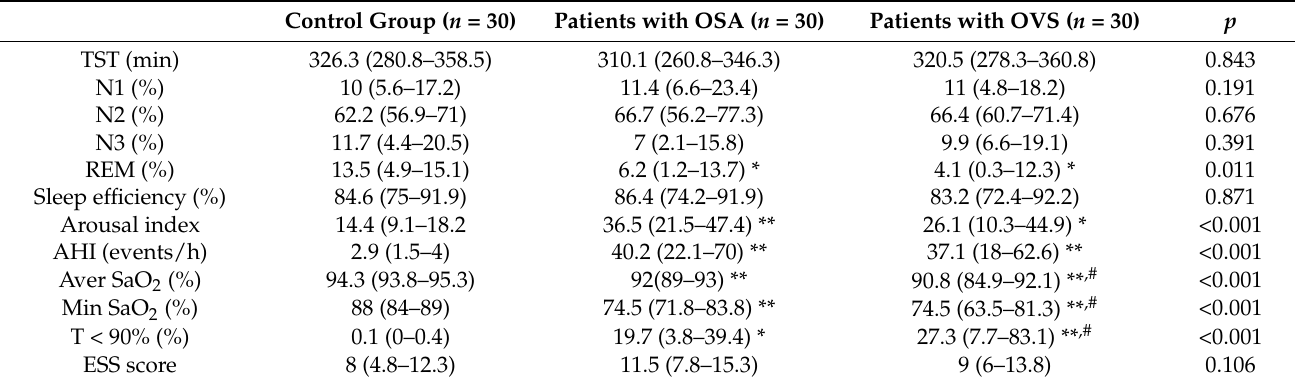
Table 2. Comparison of sleep characteristics between control, obstructive sleep apnea syndrome (OSA) and overlap syndrome (OVS)